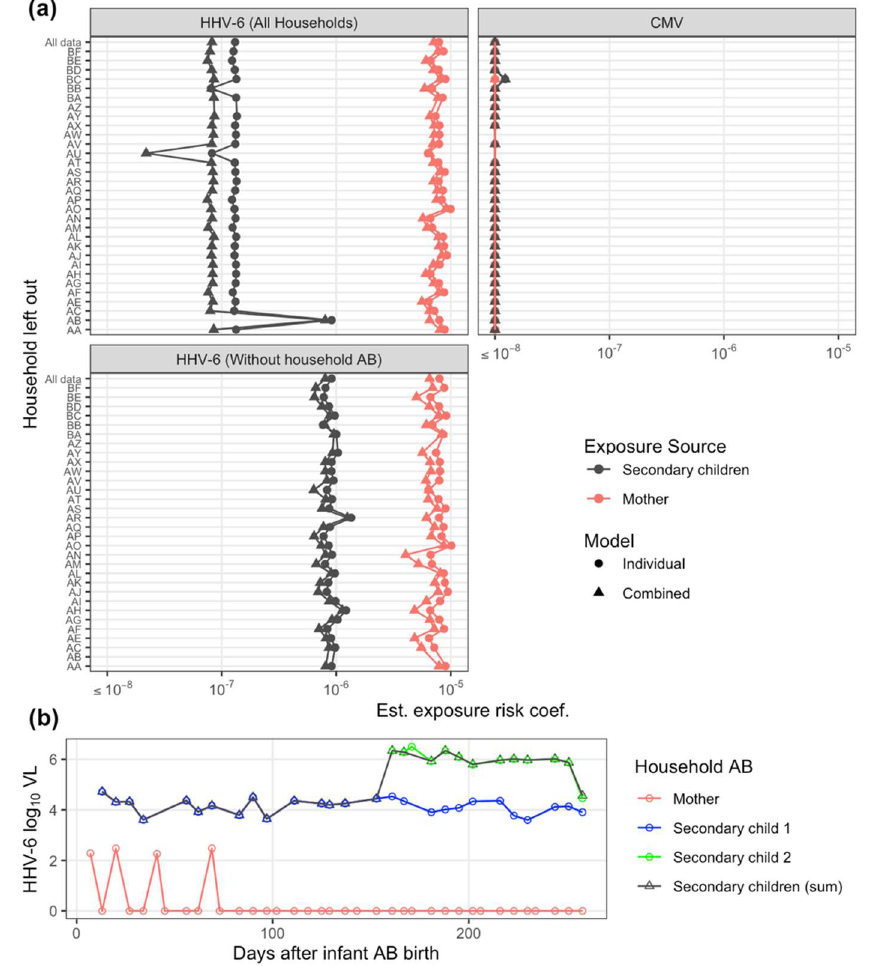
Figure A1. Transmission model sensitivity analysis to individual households. ( a ) Exposure risk coefficient estimate by exposure source and model re-estimated iteratively excluding one household at a time for both viruses; and HHV-6 was additionally evaluated completely excluding household AB. Estimates shown for both individual (single exposure) and combined exposure models. ( b ) HHV-6 viral load (VL, DNA copies/mL) for household AB by exposure sources. Infant AB was infected following the final exposure.